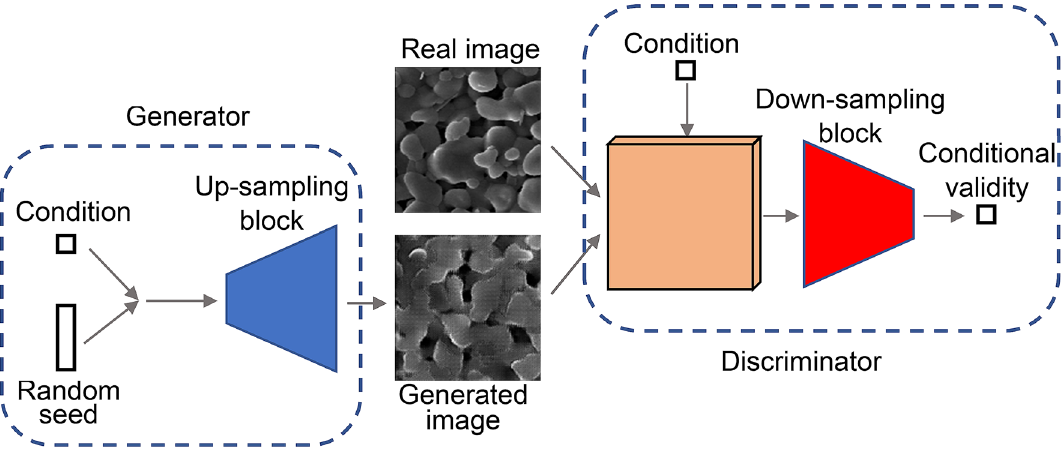
Figure 7. The structure of the